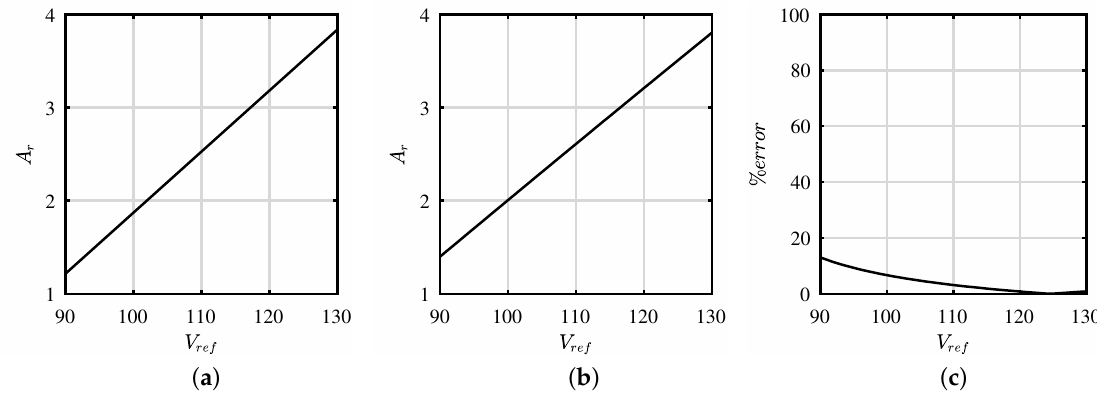
Figure 4. Value of the slope compensation. ( a ) Approach proposed in this paper. ( b ) Exact value obtained with the saltation matrix and ( c ) percentage error.